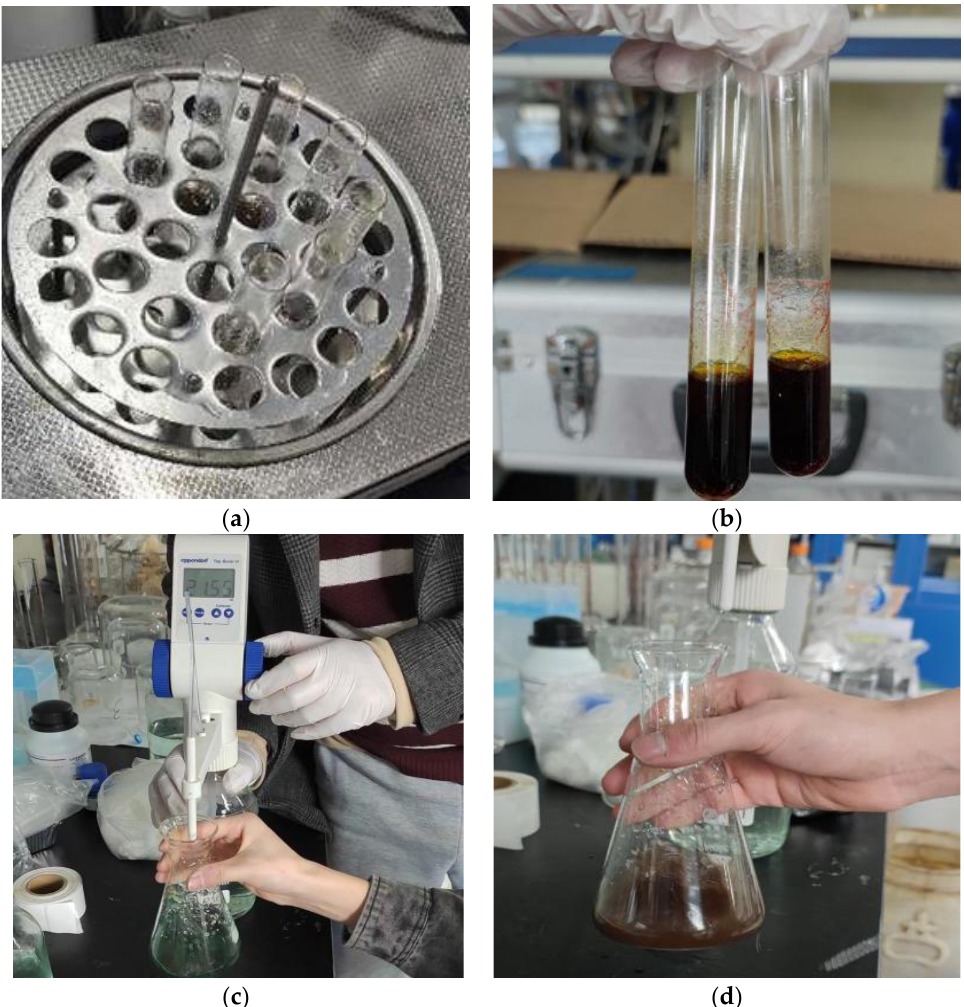
Figure 3. The procedure of organic matter test of ( a ) oil bath, ( b ) mixture after oil bath, ( c ) potassium dichromate titration, and ( d ) ending of titration.